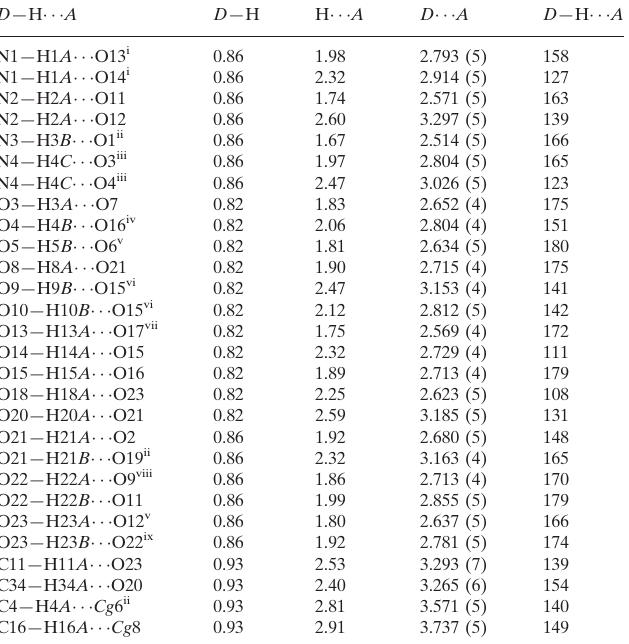
Hydrogen-bond geometry (A˚ , (cid:4) ). Cg 6 and Cg 8 are the centroids of the C33–C38 and C47–C52 rings,